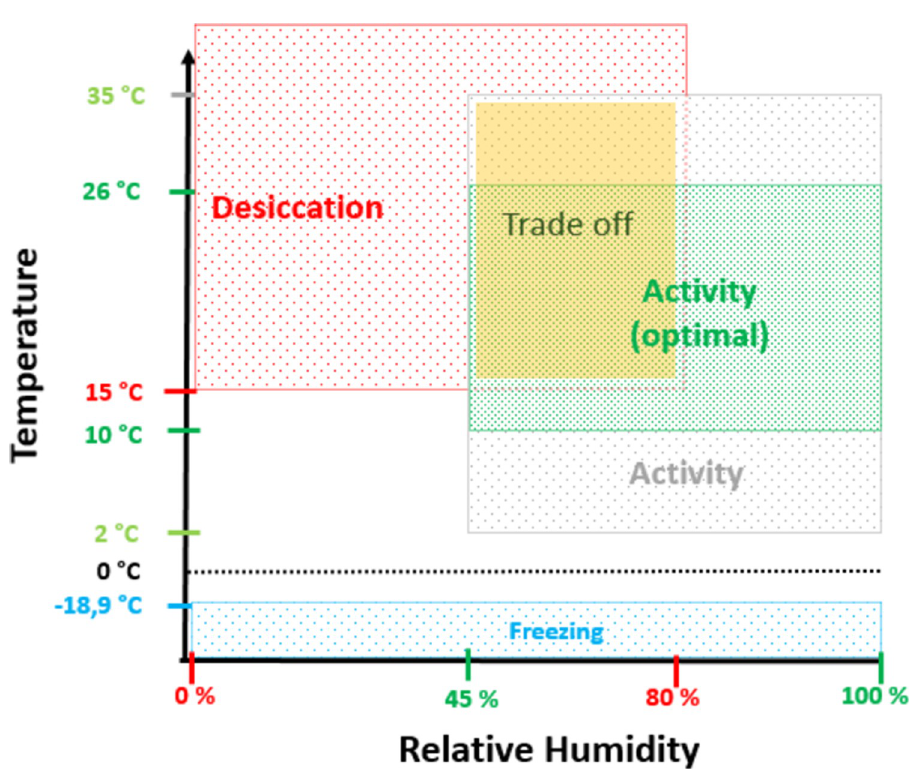
Fig 2. Trigger values of the climate parameters and the induced change of behaviour state of the ticks. Optimal conditions for tick activity is given in green, conditions leading to desiccation or freezing in red and blue, respectively. The overlap between the areas admitting activity and implying desiccation illustrates the trade off each individual tick faces when deciding whether to become active for host-seeking or to stay inactive to conserve humidity (indicated in